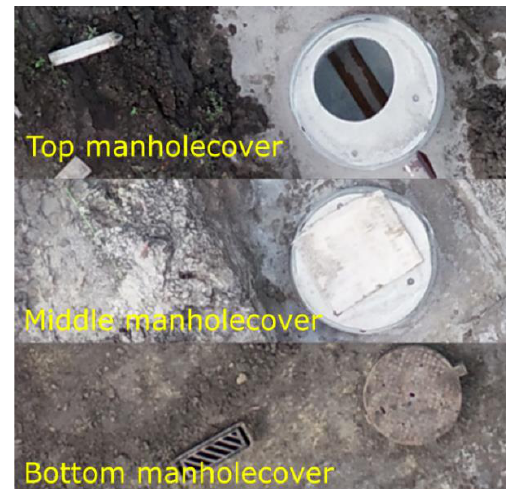
Figure 12. The three different manhole covers in detail from the construction site where the two manhole covers on top aren’t finished and the one on the bottom